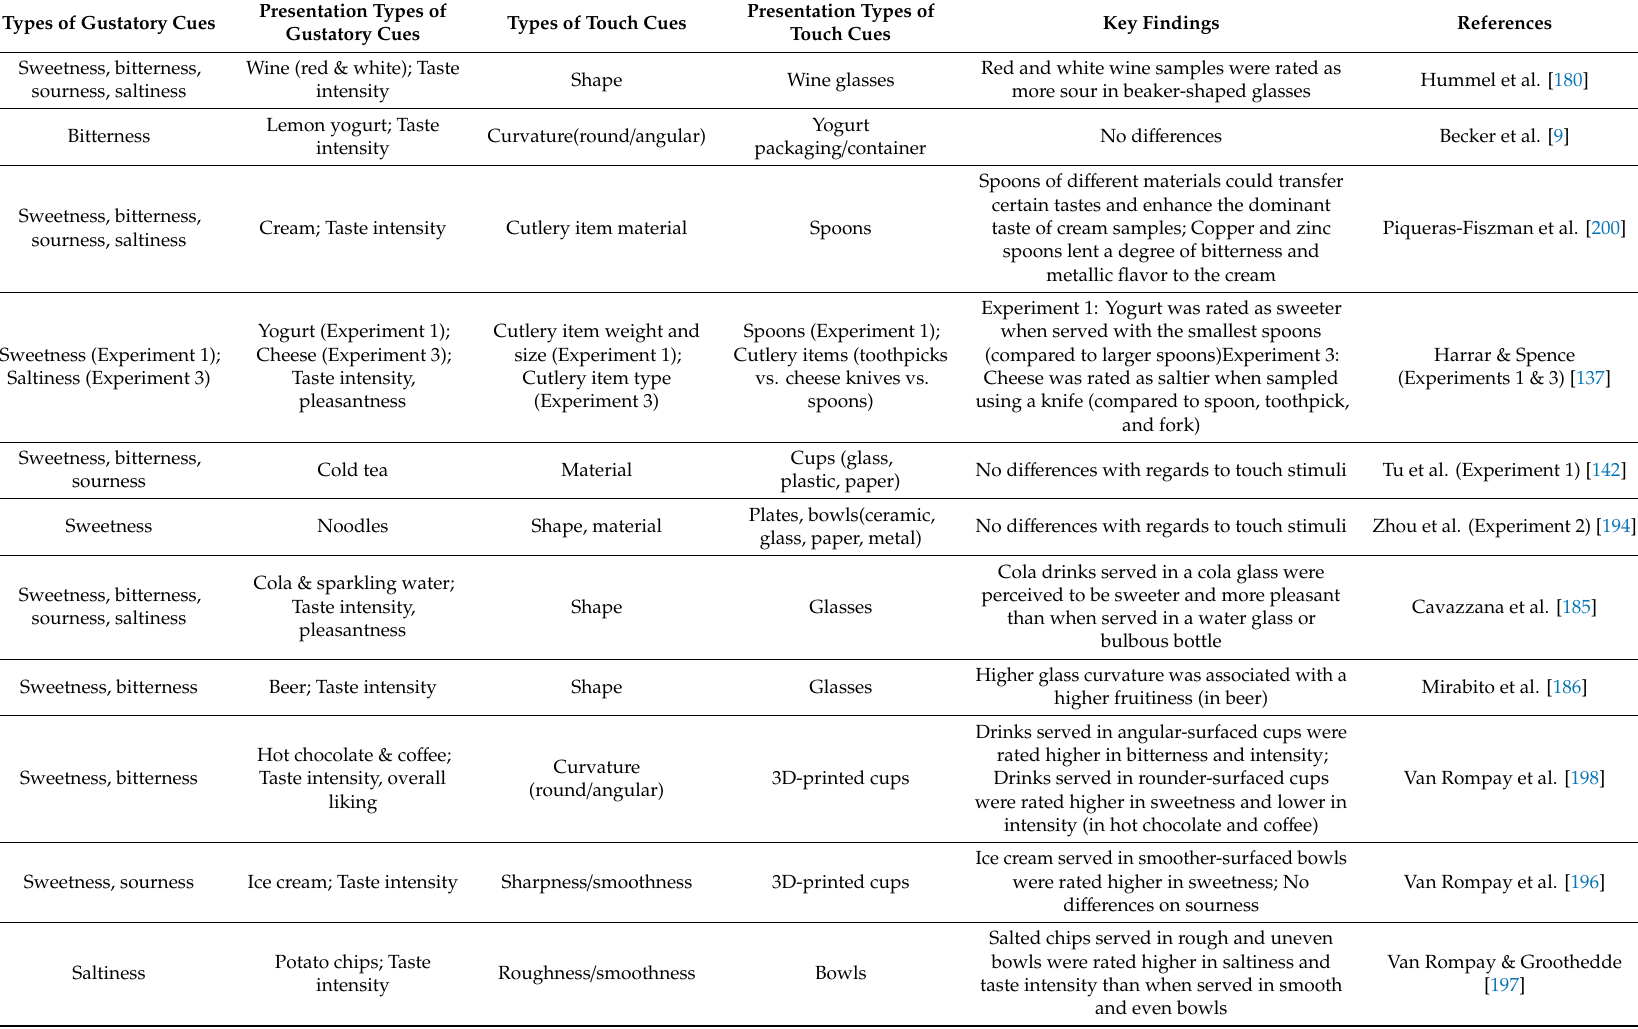
Table 4. The summary of findings regarding cross-modal associations between gustatory and hand-feel touch